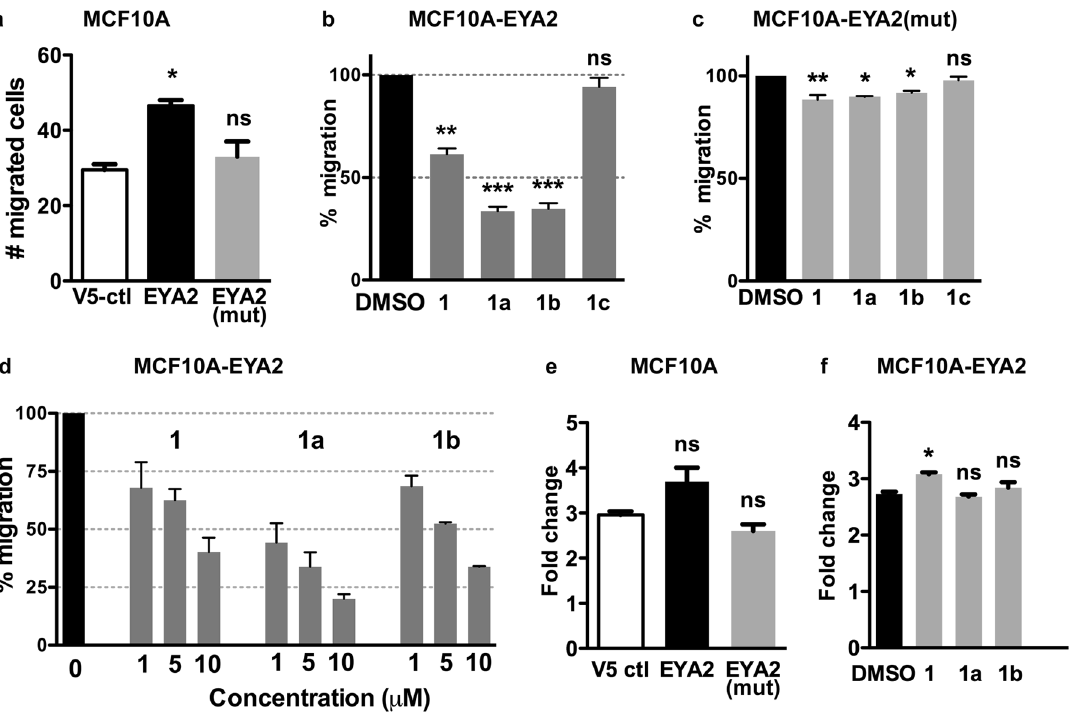
Figure 5. EYA2 overexpression in MCF10A cells increases cell motility, which in turn is inhibited by EYA inhibitors. ( a ) Trans-well migration of MCF10A cells transfected with either pcDNA 3.2/V5-DEST (V5 vector control), V5-EYA2, or the phosphatase dead mutant V5-EYA2(mut). ( b ) MCF10A-EYA2 cells were treated with 7.5 m M of compounds 1, 1a, 1b, or 1c. Percentage migration relative to cells treated with the vehicle (0.1% DMSO) is shown. ( c ) Transwell migration of MCF10A-EYA2(mut) cells in the presence of 7.5 m M of compounds 1, 1a, 1b, or 1c ( d ) Relative migration of MCF10A-EYA2 cell migration by compounds 1, 1a, and 1b when treated with the doses indicated on the x-axis. ( e ) Change in cell density of MCF10A- V5 ctl, MCF10A-EYA2 and MCF10A-EYA2(mut) cells after 48 hours measured using the MTT assay. ( f ) Change in cell density of MCF10A-EYA2 cells after 48 hours in the presence of either vehicle control (0.1% DMSO) or 10 m M compounds 1, 1a, and 1b. For transwell migration experiments each bar represents the mean (and standard error) of five random fields per filter and two wells per experiment. For proliferation experiments each bar represents the mean (and standard error) of three experiments. The p -values were calculated by one-way ANOVA followed by a Tukey post test. ns is not significant, * p , 0.05, ** p , 0.01, *** p , 0.001. In each case the p value shown is relative to the V5-control or the vehicle-treated sample.